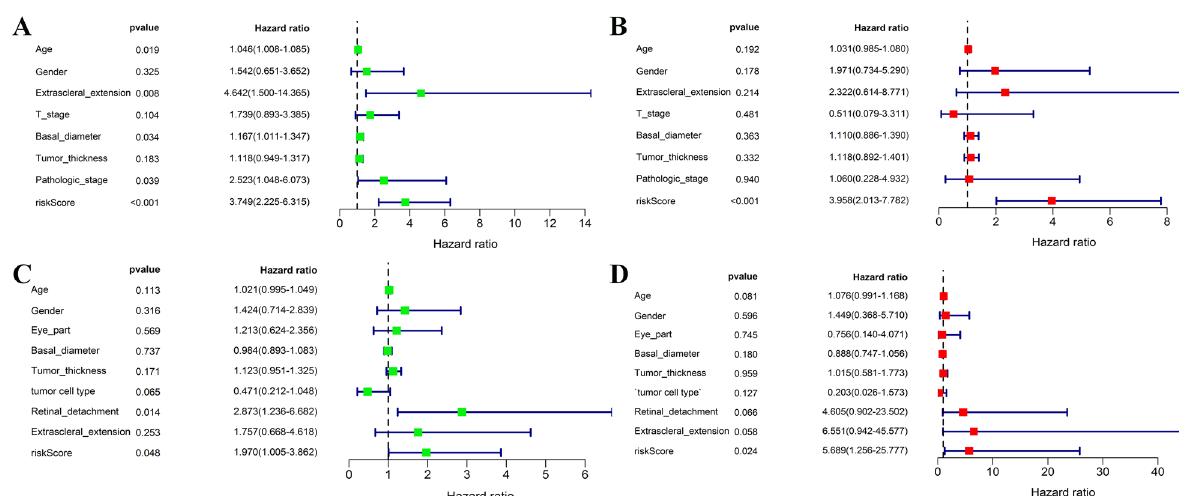
Figure 5. Univariate and multivariate Cox regression analyses for the risk score combined with the clinical characteristics. Univariate analysis for the training cohort ( A ). Multivariate analysis for the training cohort ( B ). Univariate analysis for the validation cohort ( C ). Multivariate analysis for the validation cohort ( D ). The figure was performed using R software (version 3.3.1, Vienna, Austria, https:// www.r- proje ct.